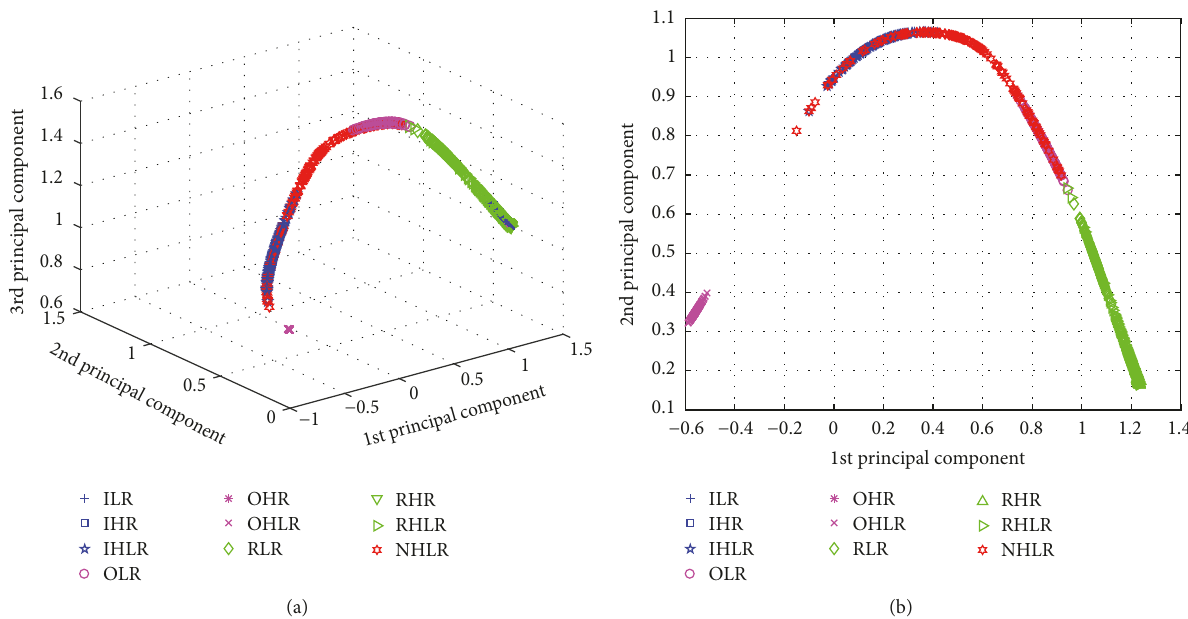
Figure 15: Feature visualization maps of standard SAE in Experiment 3. (a) The first three PCs; (b) the first two PCs.